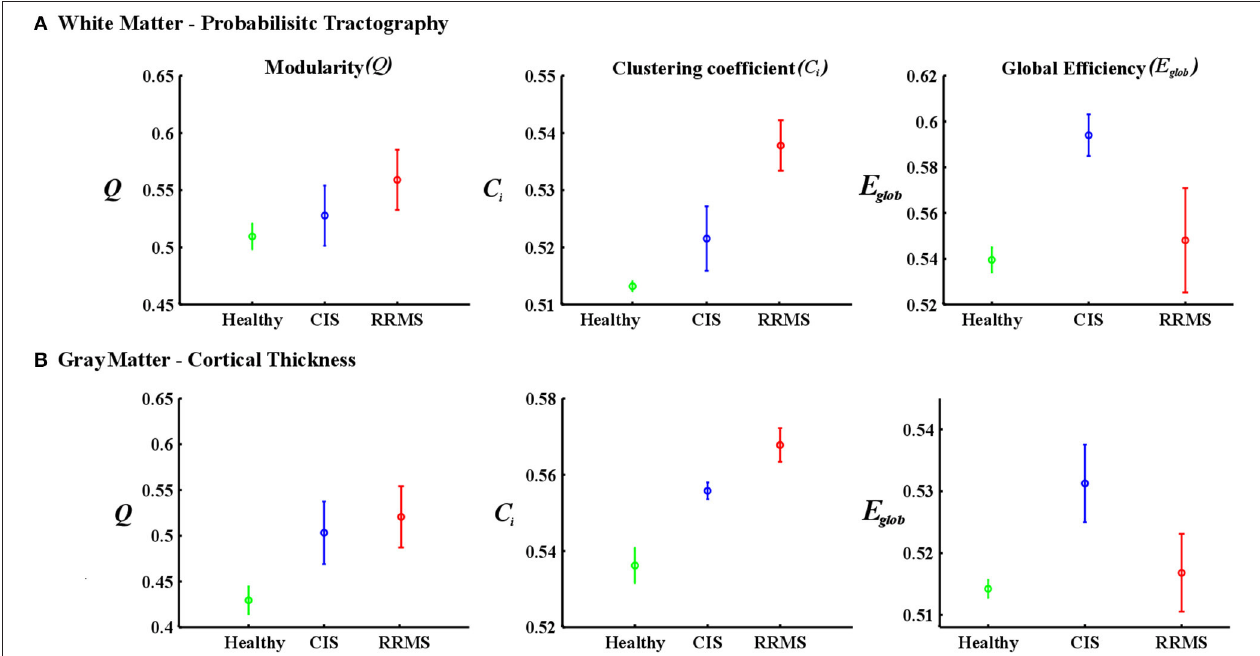
FIGURE 5 | Mean values and standard deviations over investigated densities. (A) The first row is for the white matter-probabilistic tractography and (B) the second row is gray matter cortical thickness. The healthy group is represented in green, the CIS in blue and the RRMS in red.